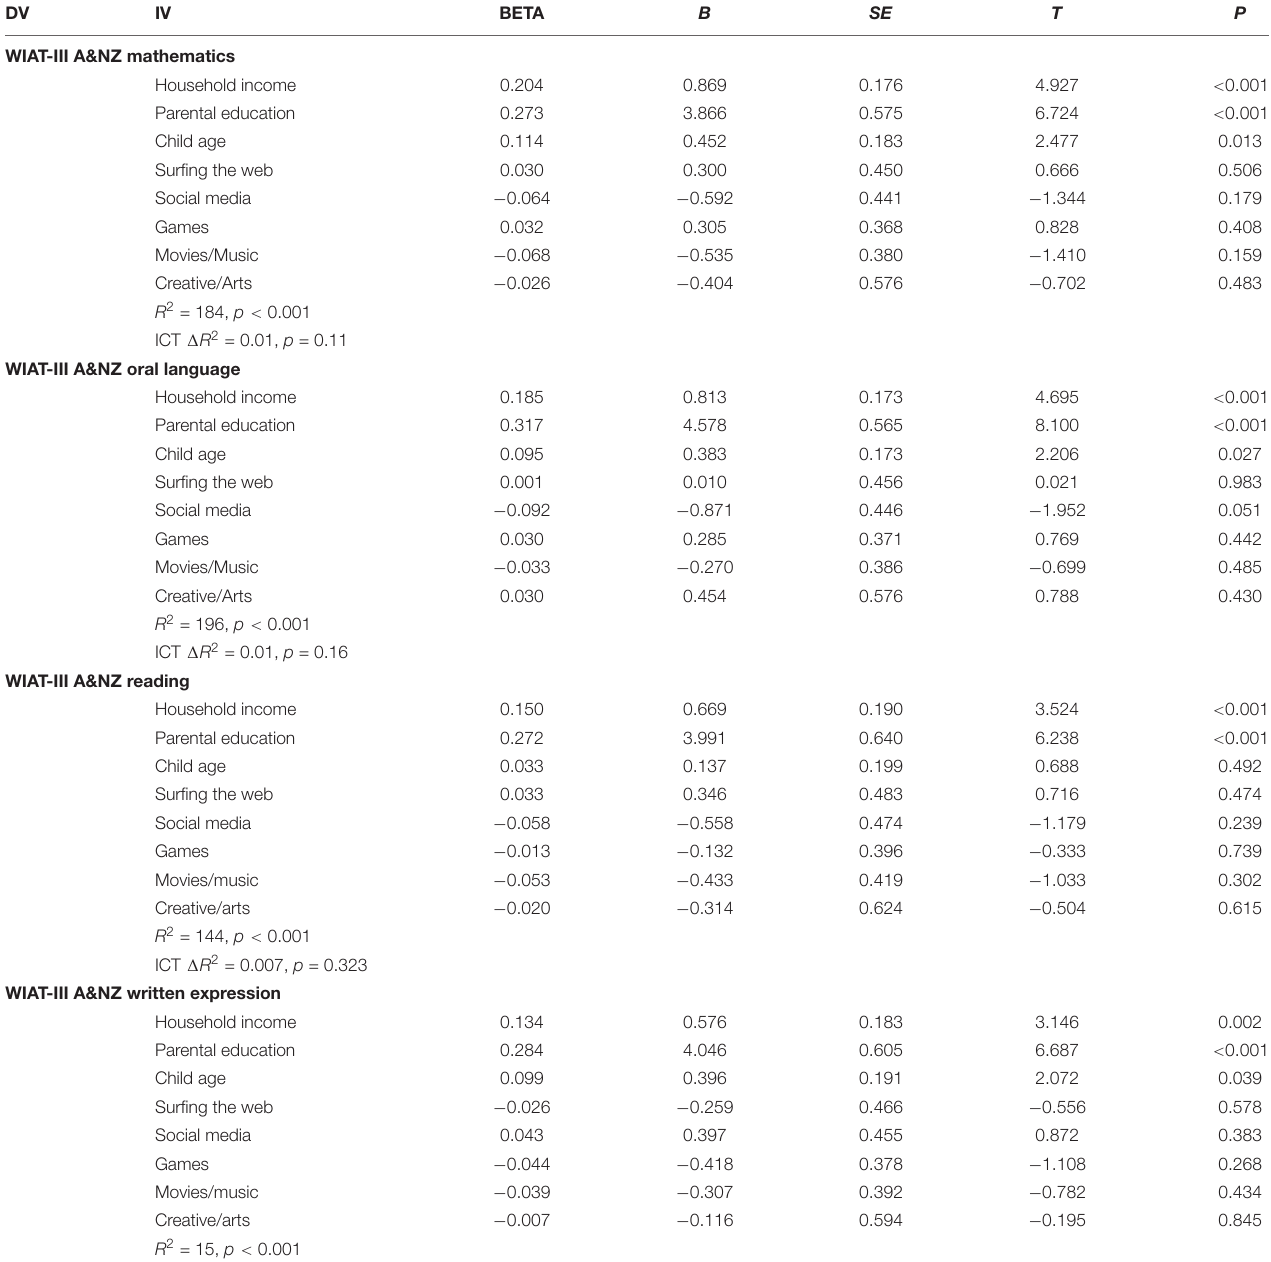
TABLE 6 | Sequential multiple regression of recreational ICT use for WIAT-III A&NZ Academic